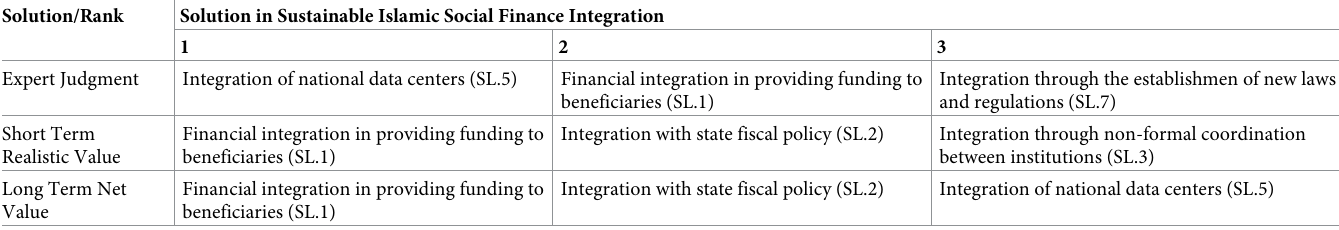
Table 5. Summary of priority